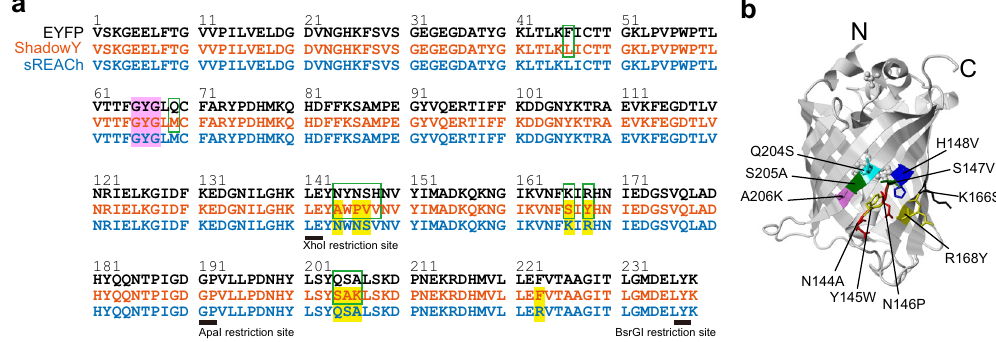
Figure 1. Sequence alignment of EYFP, ShadowY, and sREACh. ( a ) Green rectangles indicate the differences between ShadowY and EYFP. Yellow boxes indicate the differences between ShadowY and sREACh. The chromophore tripeptide is highlighted with the magenta box. ( b ) X-ray crystal structure of EYFP (Protein Data Bank ID: 3V3D). The mutated amino acid positions except F46L and Q69M are indicated.